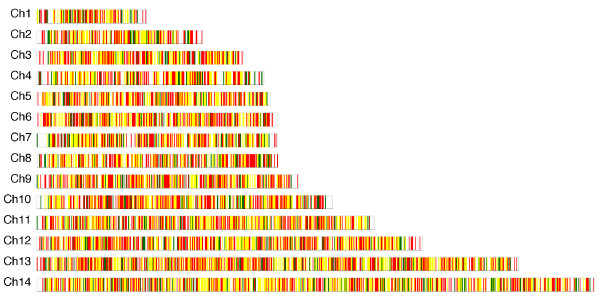
Diagram of the 14 P. falciparum chromosomes showing positions of potentially expressed genes. Expressed sequence tags (EST) from our libraries or from public databases were assembled against predicted coding sequences in PlasmoDB; genes that matched our EST only (green), EST already in public databases (red), or both (yellow) are displayed according to gene order on the chromosomes. Those in white are CDS that were not covered by any EST. Approximately 70% of the 5485 predicted CDS were matched with one or more EST.